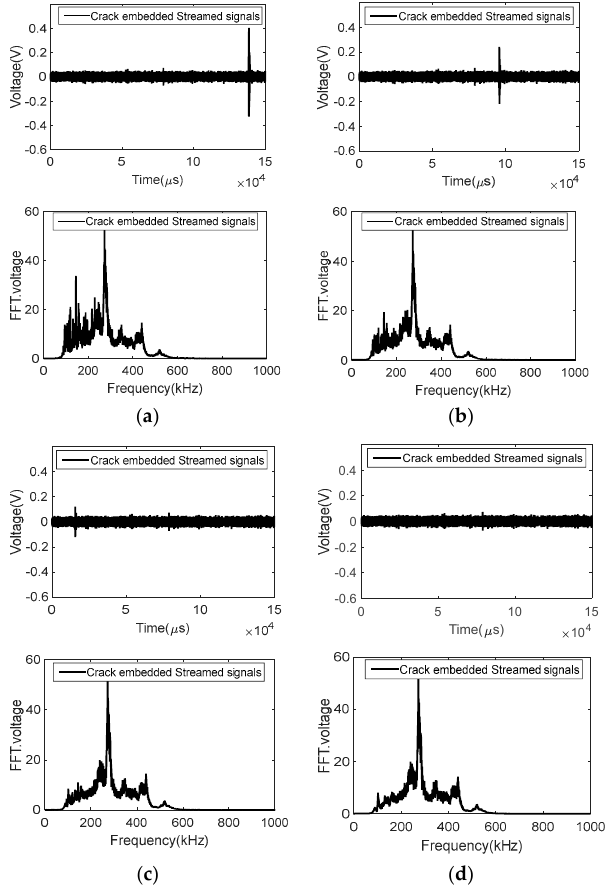
Figure 9. The comparison of embedded cracking streamed signals, ( a ) SNR = 7.5, ( b ) SNR = 4.0, ( c ) SNR = 2.0, and ( d ) SNR = 1.0.